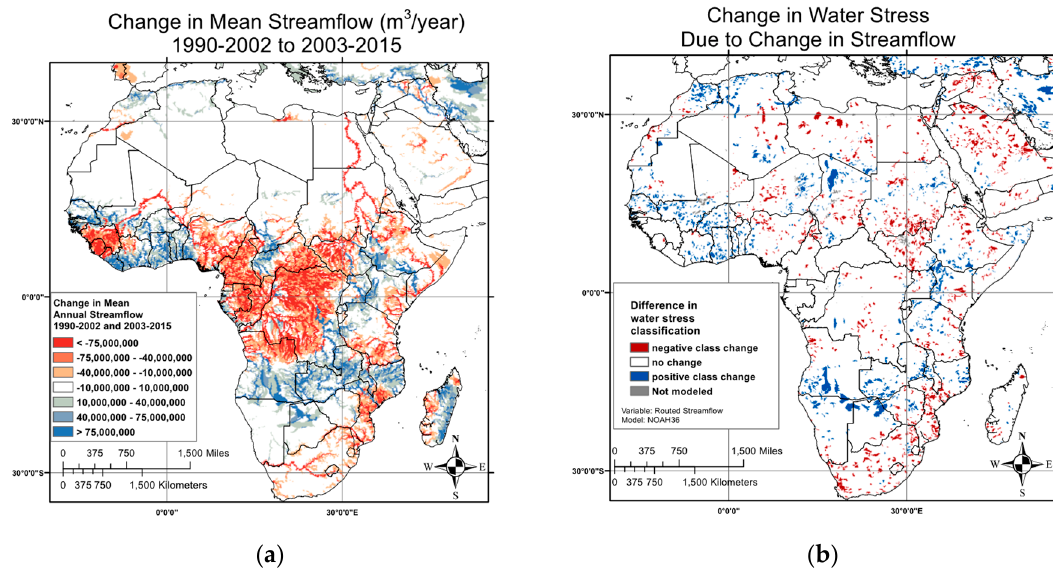
Figure 4. ( a ) Difference in mean annual streamflow between 1990–2002 and 2003–2015; ( b ) change in Falkenmark water-scarcity class due to hydrologic change (using WorldPop 2015 population). Change is ± 1 class following patterns in streamflow change, with the exception of a few basins in central Kenya, central Mozambique, and South Africa.